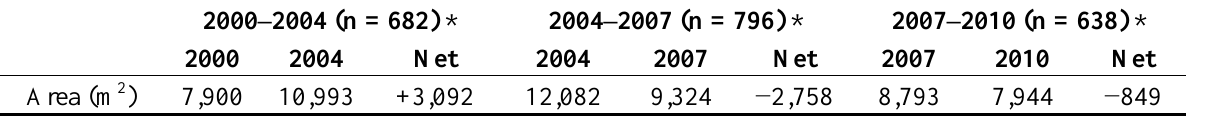
Table 2. Quantitative net changes of total eroded